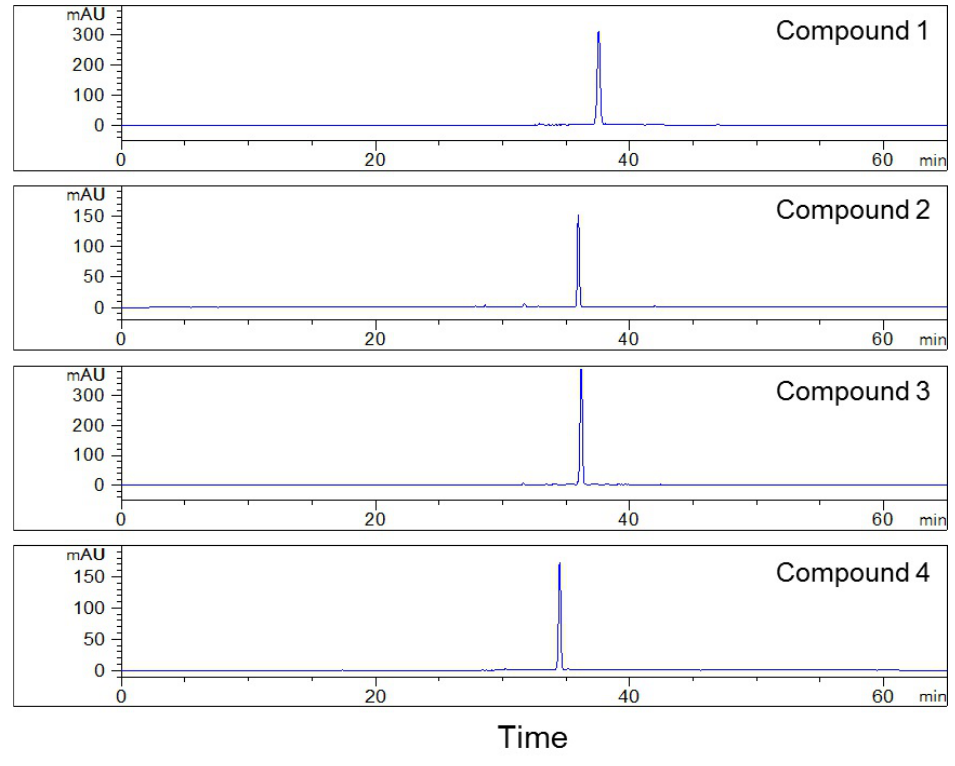
Figure 4. Purity evaluations of the separated compounds on the YMC-Pack ODS-AQ column (250 × 4.6 mm). Conditions: mobile phase: A: 0.2% formic acid in water, and B: acetonitrile; gradient: 0–50 min, 10%–30% B, 50–65 min, 30% B; flow rate: 1.0 mL/min; column temperature: 25 °C; monitoring wavelength: 269 nm.